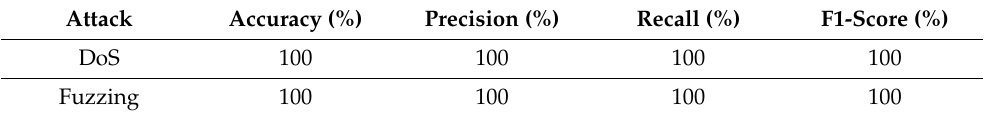
Table 2. Evaluation results obtained with IBM QRadar SIEM using a rule-based method. Attack Accuracy (%) Precision